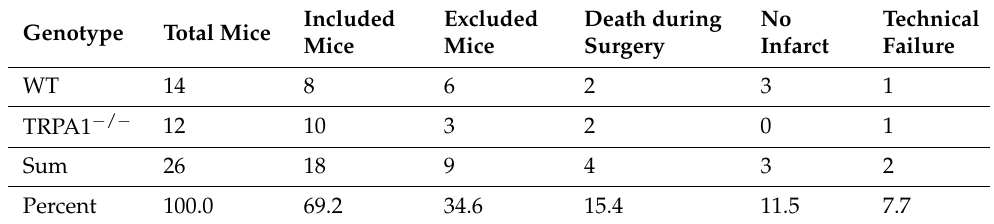
Table A2. Mouse exclusion criteria. The total number and the number of included and excluded mice per genotype. The excluded mice are additionally separated by the reason for exclusion, which were death during surgery, no visible infarct, or technical failure during